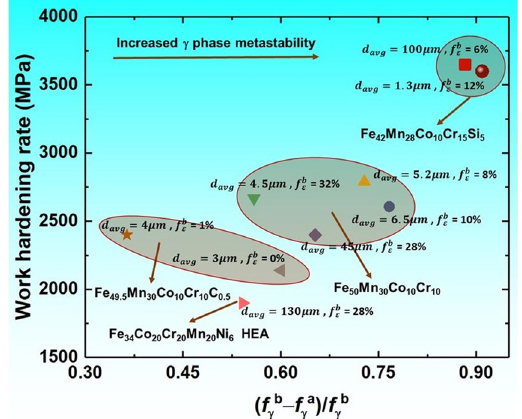
Figure 5. Work hardening rate plotted as a function of fractional change in γ phase after complete tensile deformation for all TRIP assisted HEAs designed till date 1–4,23,25 . ( f γ b = fraction of γ phase before tensile deformation; f γ a = fraction of γ phase after tensile deformation; f ε b = fraction of ε phase before tensile deformation; d avg = average grain size after respective thermomechanical